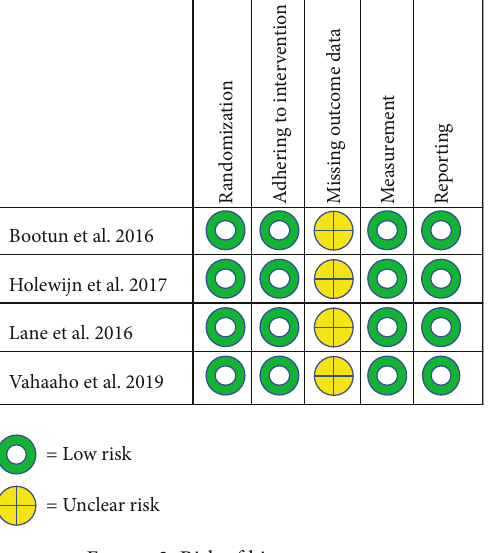
Figure 2: Risk of bias assessment. Table 2: GRADE assessment.